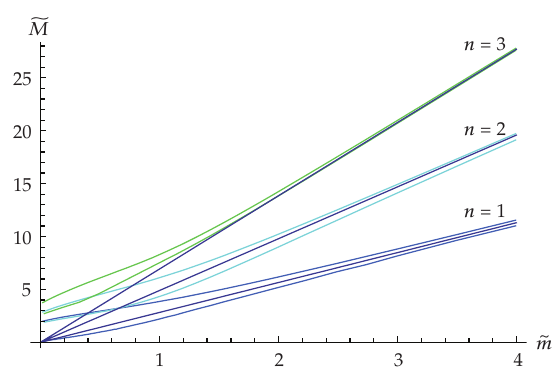
Figure 5: There is Zeeman splitting of the states due to the magnetic field. In the absence of the field, there are three straight lines emanating from the origin; these are split to form six curves. At zero bare quark mass (cid:3) the end of the lowest curve (cid:4) , there is indeed a massless Goldstone mode. The straight lines correspond to the asymptotic AdS results.